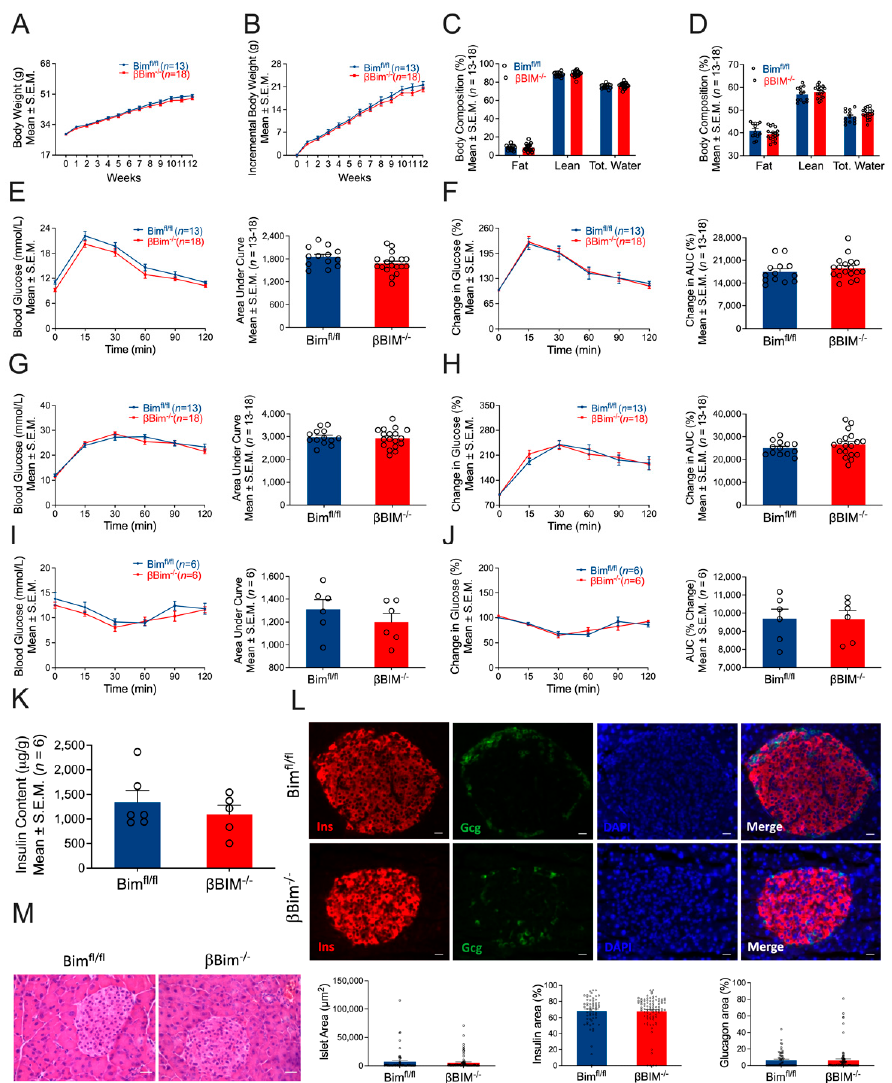
Figure 4. Effect of high-fat diet on glucose homeostasis of β Bim -/- mice. β Bim -/- mice were subjected to a high-fat diet regimen for 12 weeks. Body weight was measured weekly ( A , B ). Body composition (fat mass, lean mass, and total water) was measured before and after 12 weeks of high-fat diet feed- ing ( C , D ). Glucose tolerance tests measured before ( E , F ) and 12 weeks after high-fat diet feeding ( G , H ) did not show change in β Bim -/- mice compared to Bim fl/fl mice. Similarly, an insulin tolerance test measured one week after the IPGTT did not show any difference between the two genotypes ( I , J ). Pancreatic insulin content was measured in an acid–ethanol extracted fraction using a com- mercial ELISA kit ( K ). Pancreatic sections were stained for insulin, glucagon, and DNA ( L ). Bottom panel ( L ) showing islet area, insulin, and glucagon positive cells (calculated as % of total islet area). Representative of 3 mice per genotype. Scale bar, 20 µm. Histology of mouse pancreas stained by Hematoxylin and Eosin ( M ). Scale bar, 25 µm. Data are presented as Mean ± SEM. 4. Discussion The importance of alternative splicing in diabetes and pancreatic β -cell function is gaining interest. Previous findings have suggested an important role for NOVA1 in pan- creatic β -cell function and survival including the following: (i) studies showing expression